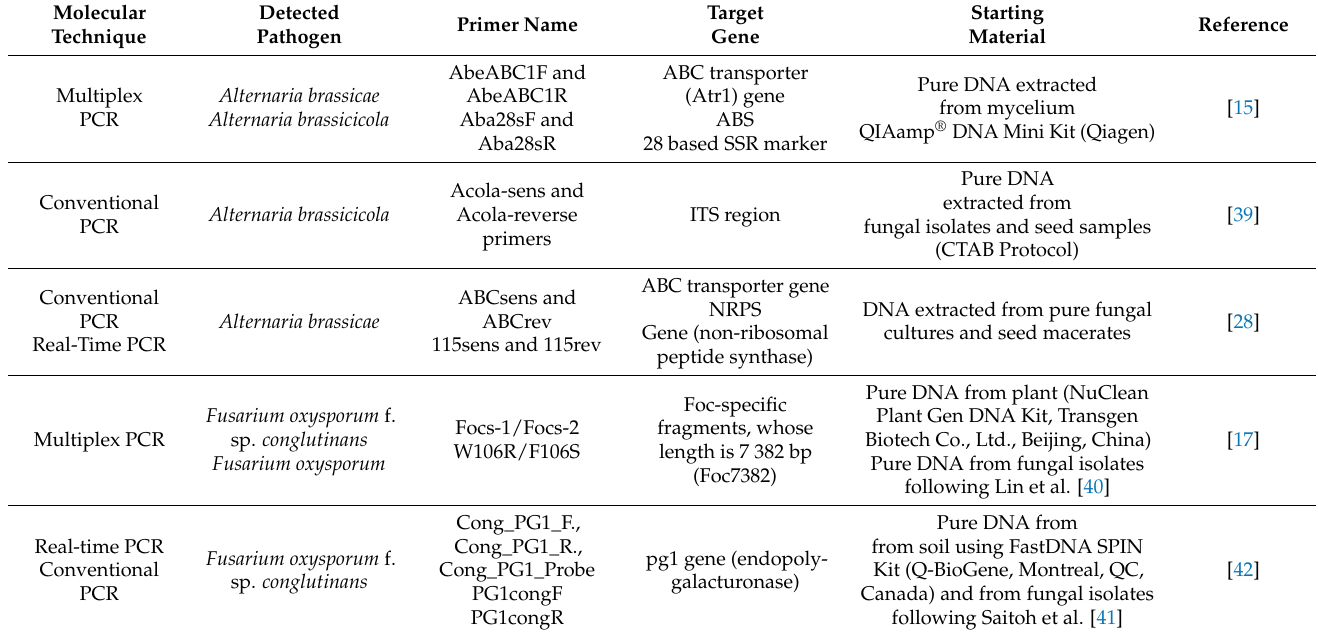
Table 1. Summary of the main molecular techniques employed for detection of brassica fungal